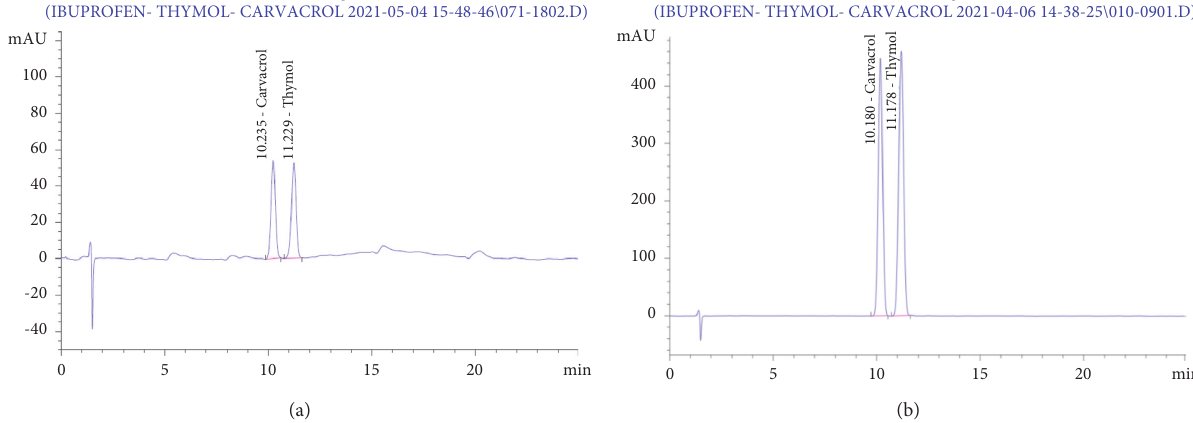
Figure 2: Chromatograms of thymol and carvacrol standards. 0.01mg/ml thymol and carvacrol standards (a) and 0.1mg/ml thymol and carvacrol (b) were injected to HPLC using the developed method. Table 1: Thymol and carvacrol content in Za’atar extracts using olive oil, sunflower oil, and sesame oil for extraction. Oil used for extraction